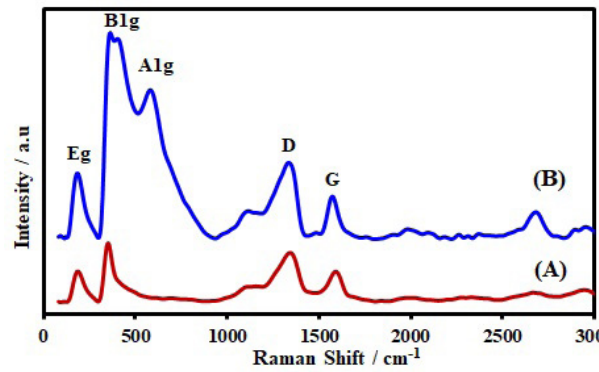
Fig. 4. Raman spectra of RGO (A), and RGO/TiO